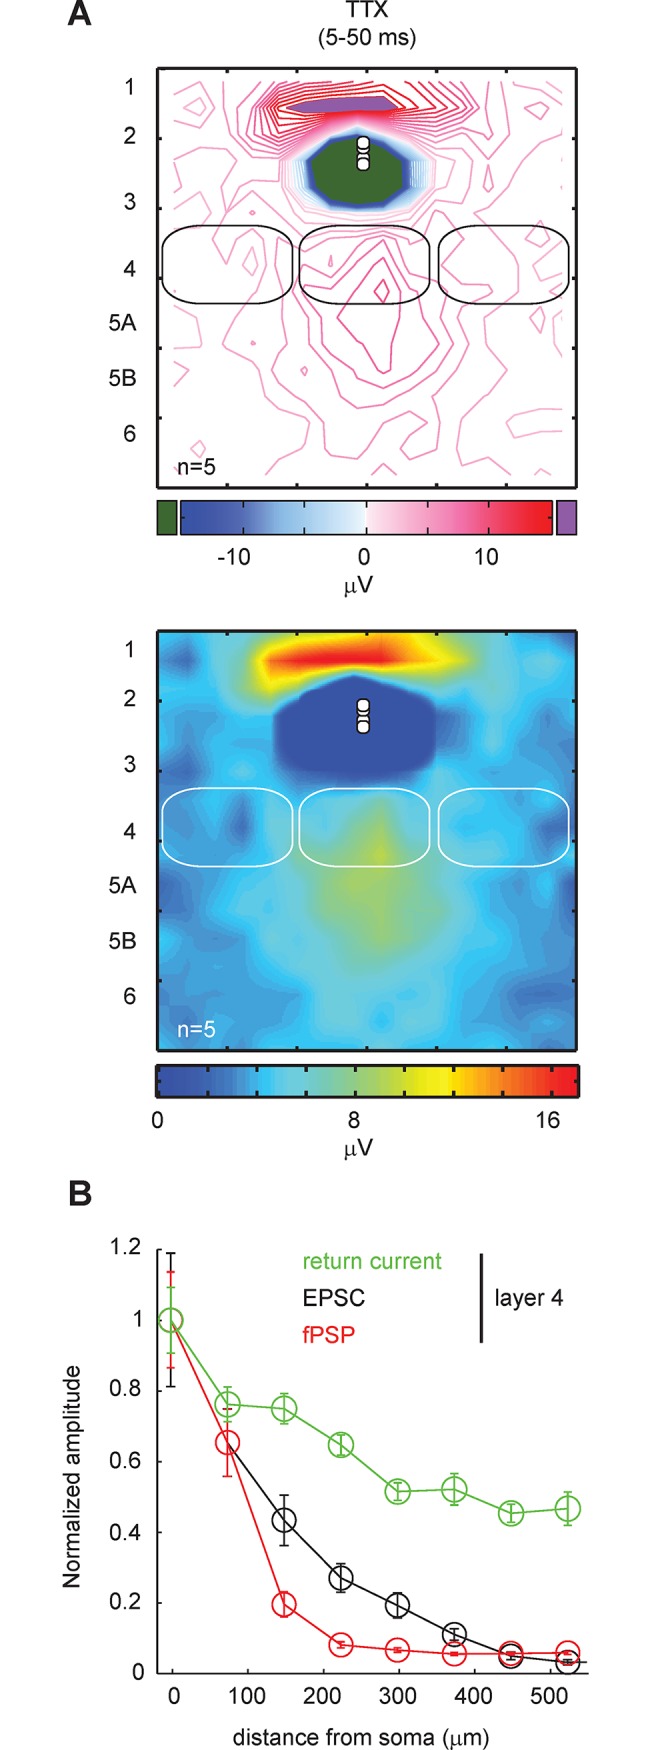
Return currents of direct depolarizations alter the pattern of synaptic inputs in the fPSP maps.
A, Top panel, an averaged isoline map showing the mean amplitude of direct evoked potentials measured in the synaptic window (5–50 ms post stimulus onset) in the presence of TTX. The red isolines show the positive potentials, the blue the negative potentials. Return currents (in red) were still detected in the synaptic window when stimulating in the layers 4 and 5. Bottom panel, the same positive return currents shown in a color map. Recordings (n = 5) were in layer 3. B, Horizontal profile of return currents evoked by stimulations in the layer 4 in the presence of TTX (green) superposed on the horizontal profiles of fPSP (red) and EPSC (black) evoked by stimulations in layer 4.